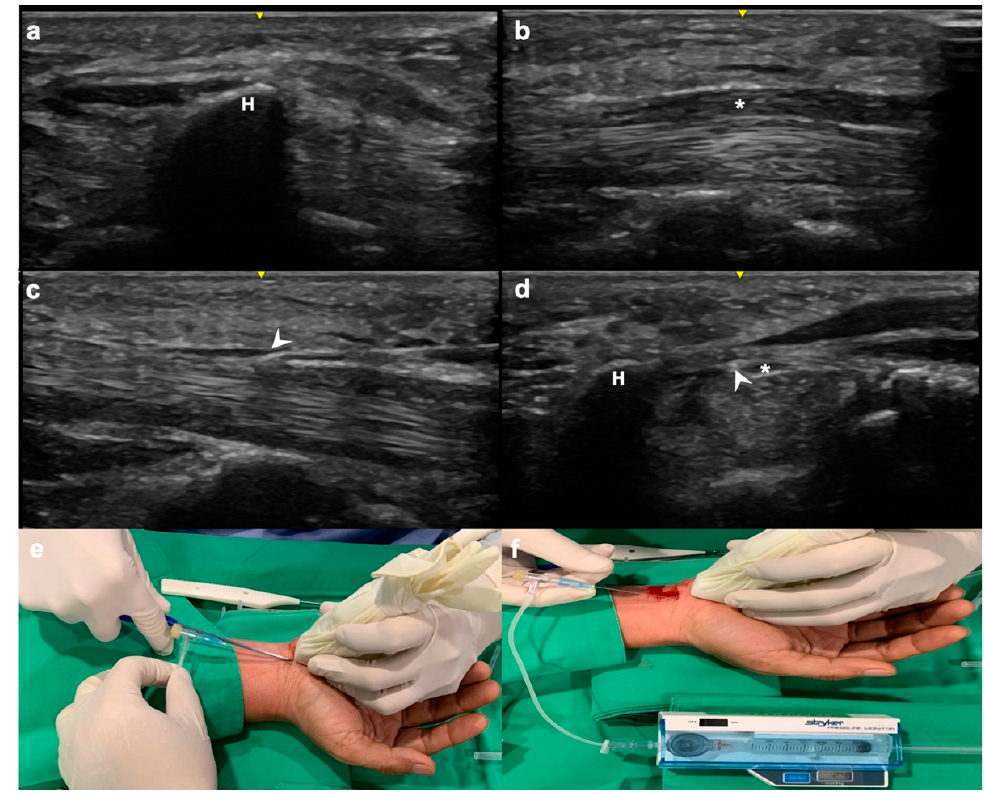
Figure 1. The step-by-step procedure of the carpal tunnel pressure (CTP) measurement and carpal tunnel release (CTR) under ultrasonographical guidance. First, the median nerve, transverse carpal ligament, and hamate hook were quickly examined using ultrasound (US). The hamate hook was aimed at the center of the region of interest (ROI) in the sagittal view ( a ). The transducer was trans- versely moved towards the radial side until the full view of the median nerve ( b ), and then moved back a little toward the ulnar side to make ROI next to the median nerve. The needle of the CTP measurement gauge was percutaneously inserted into the carpal tunnel, and the tip of the needle was placed in the center of ROI in the sagittal view to align the hamate hook in the transverse direc- tion ( c ). The transducer was turned transversely to make sure again that the tip of the CTP needle